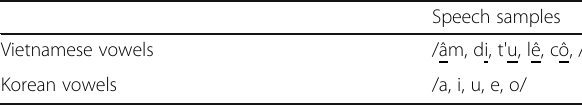
Table 2 Stimulus material for measuring